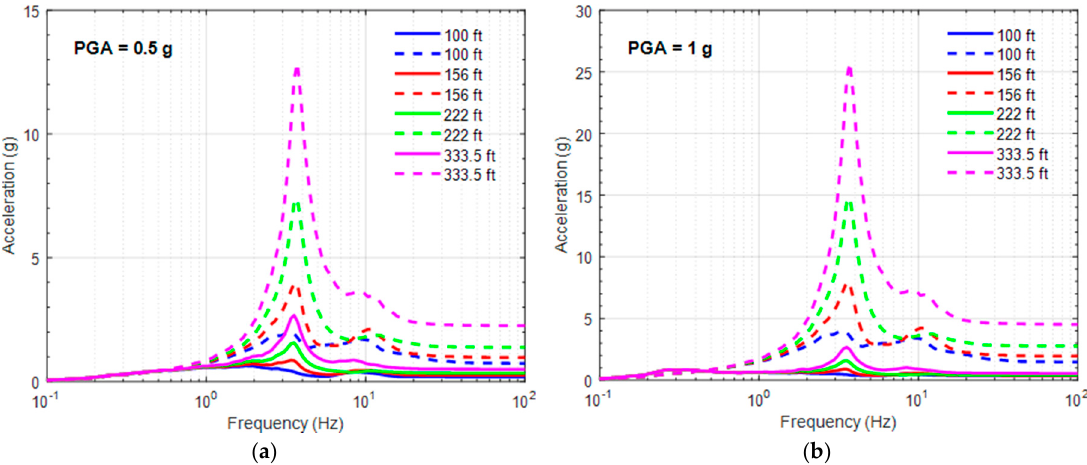
Figure 13. Comparison of FRS at different PGA from isolated ( solid lines ) and non-isolated ( dashed Figure13. ComparisonofFRSatdifferentPGAfromisolated( solidlines )andnon-isolated( dashedlines ) lines ) RCBs: ( a ) PGA = 0.5 g; ( b ) PGA = 1 g. RCBs: ( a ) PGA = 0.5 g; ( b ) PGA = 1